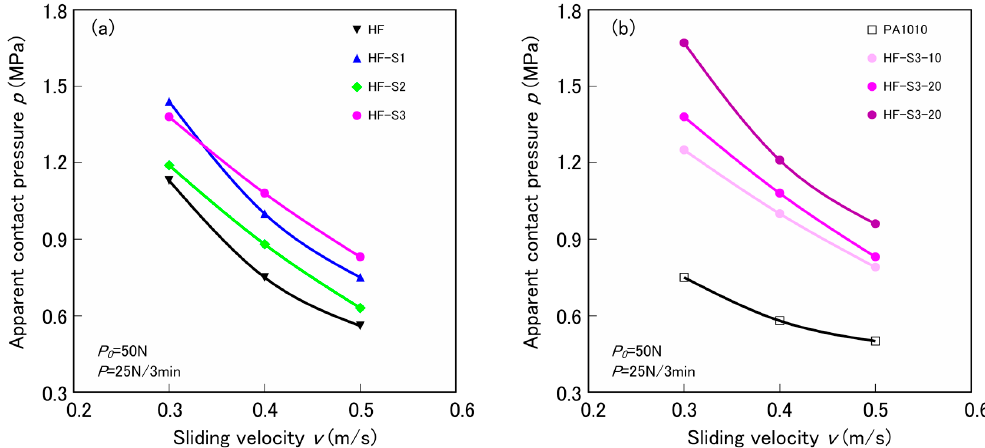
Figure 10. Apparent contact pressure as a function of sliding velocity for various surface-treated HF/PA1010 biomass composites: ( a ) Influence of type of silane coupling agent and ( b ) Influence of volume fraction of HF. Materials 2017 , 10 , 1040